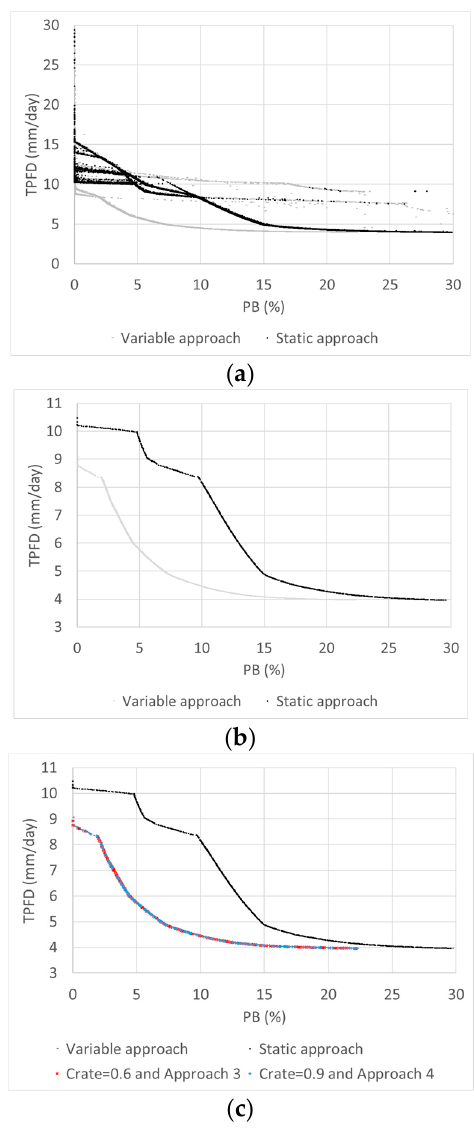
Figure 8. Comparison of the Pareto optimal solutions obtained by using static and variable approaches: ( a ) Pareto solutions identified by the two approaches, each of which was run independently; ( b ) comparison of the two global Pareto fronts, where each global Pareto front was extracted independently; and ( c ) global Pareto fronts identified by the two best cases: Crate = 0.6 and Approach 3, represented by the x symbol, and Crate = 0.9 and Approach 4, indicated by the cross symbol. For a high Crate (i.e., 0.9), Approach 4 outperformed Approach 3 with respect to all